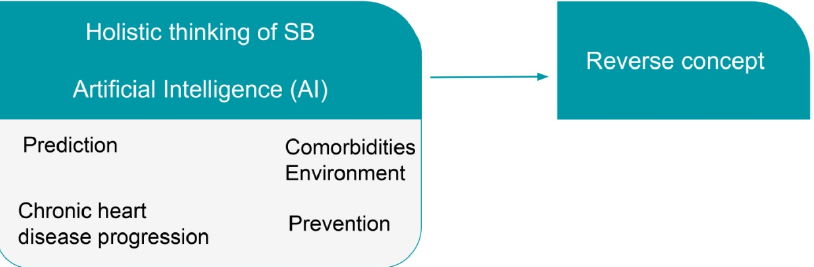
Figure 2. The holistic thinking of Systems Biology (SB), as it deals with the disease as a whole (clinical phenotype), together with the advances made by Artificial Intelligence (AI) will help to understand and explain the possibility to reverse cardiovascular diseases (CVDs) and heart failure (HF).